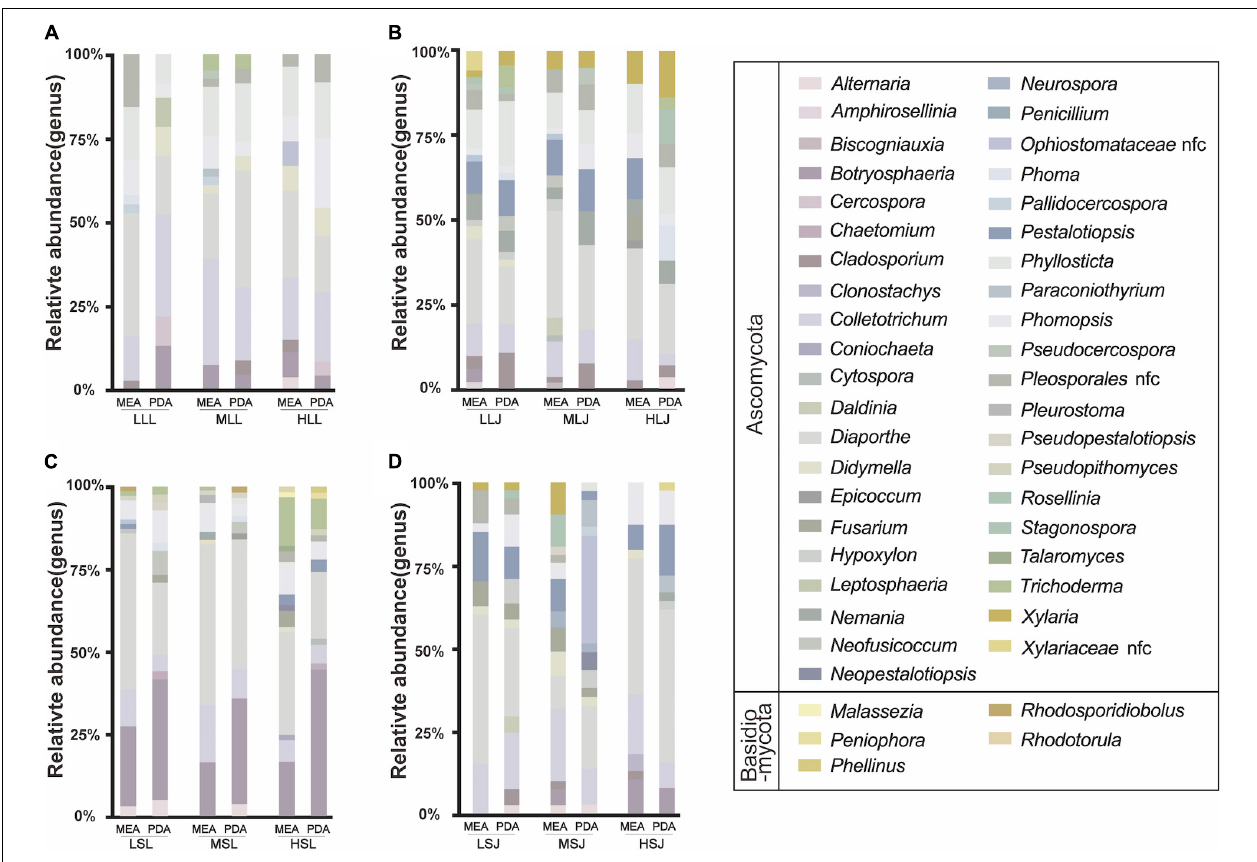
FIGURE 5 | Effects of sterilization treatments on the composition of cultured fungal endophytes from tea plant leaves (A,B) and stems (C,D) in MEA and PDA medium. LLL, MLL, and HLL represent the leaf samples from the cultivar Longjing 43 treated with 0.5, 1.0, and 2.0% of NaClO. LLJ, MLJ, and HLJ represent the leaf samples from the cultivar Jiukeng treated with 0.5, 1.0, and 2.0% of NaClO. LSL, MSL, and HSL represent the stem samples from the cultivar Longjing 43 treated with 0.5, 1.0, and 2.0% NaClO. LSJ, MSJ, and HSJ represent the leaf samples from the cultivar Jiukeng treated with 0.5, 1.0, and 2.0%